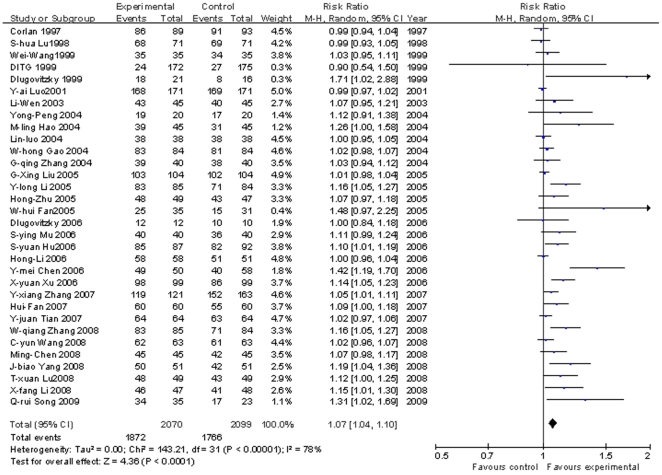
Meta analysis of sputum smear negative conversion rates in TB patients.Vertical line indicates no difference between the compared two groups (MV vs. control). Squares indicate point estimates of risk ratio (RR) in each individual study, the size of the squares indicates the weight of the corresponding study in the meta-analysis, 95%CIs of point estimates are shown by horizontal lines. Pooled RR and its 95%CI are shown by diamond shape. (It is the same in Figures 3, 4, 5, 6.)